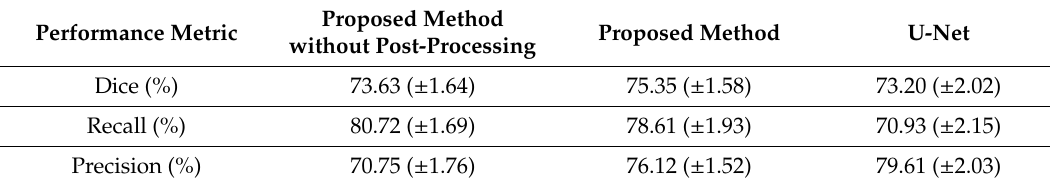
Table 1. A comparison of the mean of the segmentation performance metrics before and after post-processing as well as the performance of the baseline U-net architecture. Numbers in parentheses are 68% standard error of the